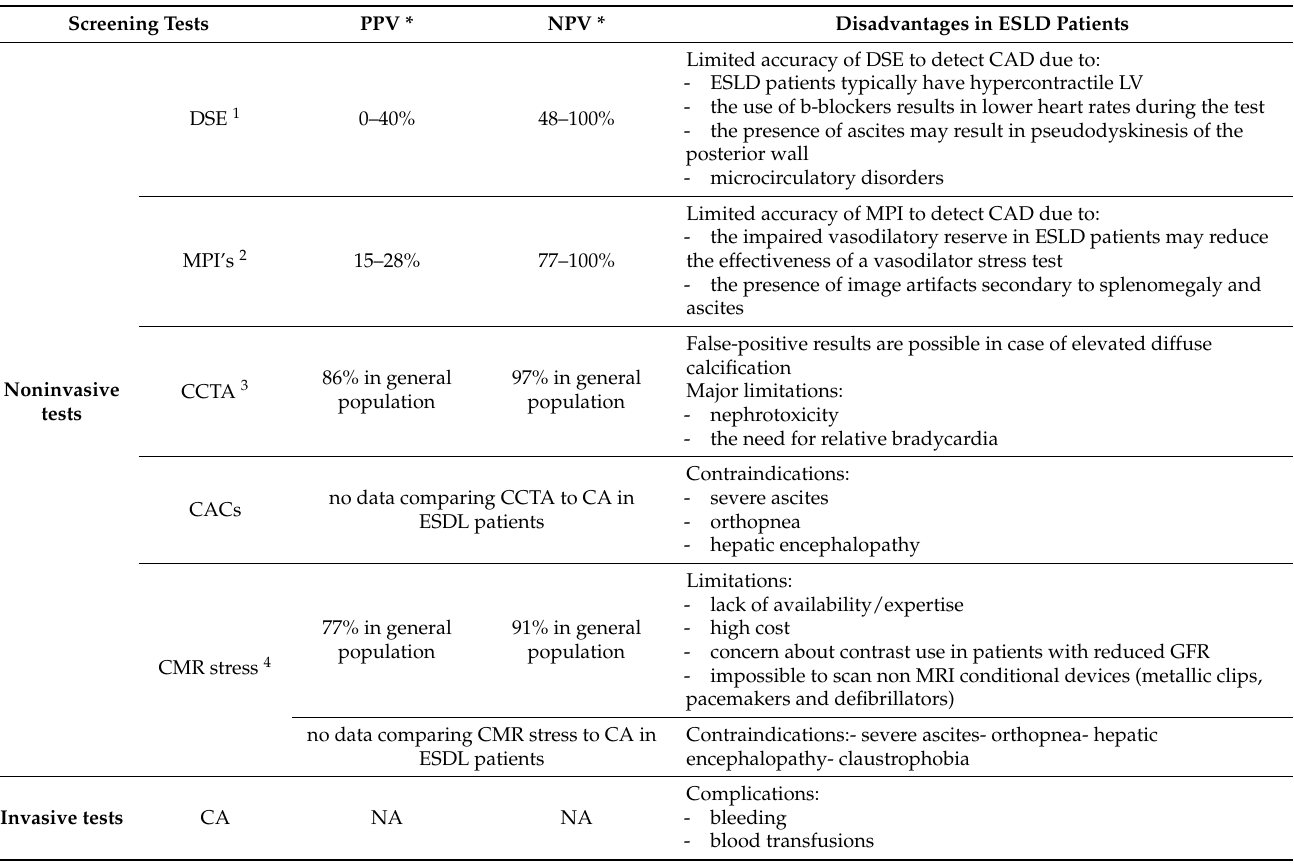
Table 1. Preoperative assessment of CAD in ESLD